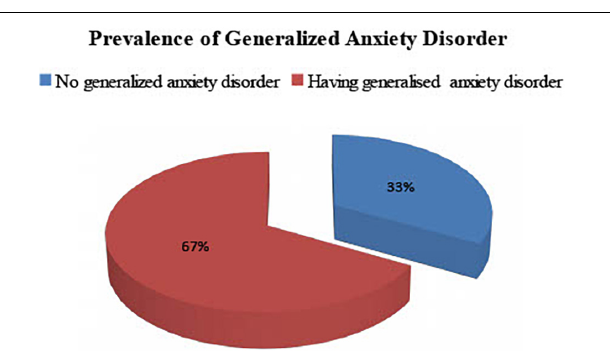
FIGURE 2 | Generalized anxiety disorder during COVID-19 pandemic, among Dessie town prisoners, in Dessie Amhara region, Northeast Ethiopia, October 2020; ( n =